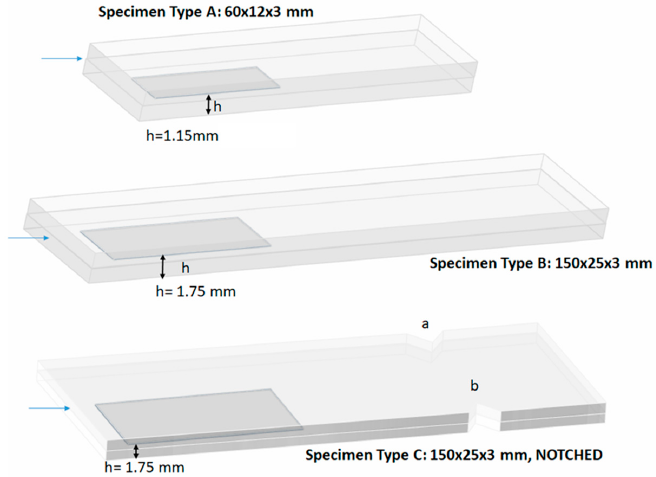
Figure 2. The three main slab types tested with built-in M-sensor. Type-A, -A blanc: slabs for DMA testing, Type-B: slabs for high-amplitude vibration, Type-C1, -C2: notched slabs for damage diagnosis with one (-C1), or two (-C2) notches at points a, b. Arrows on the left sides of slabs denote neutral axis in bending levels.